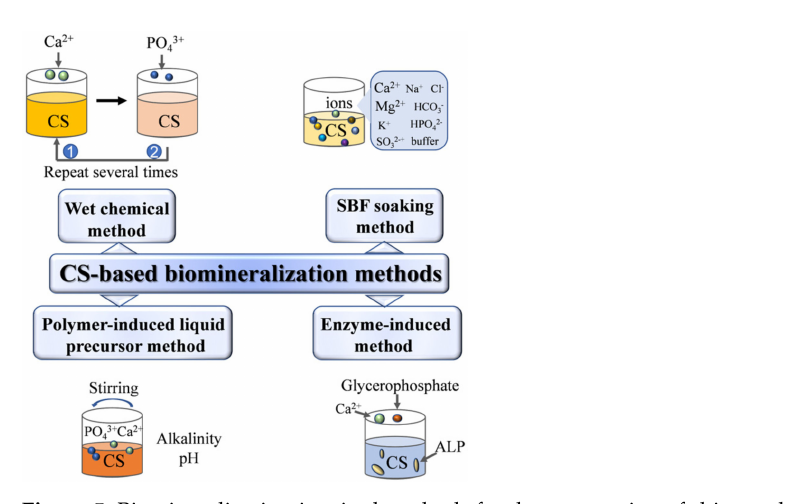
Figure 5. Biomineralization-inspired methods for the preparation of chitosan-based hybrid